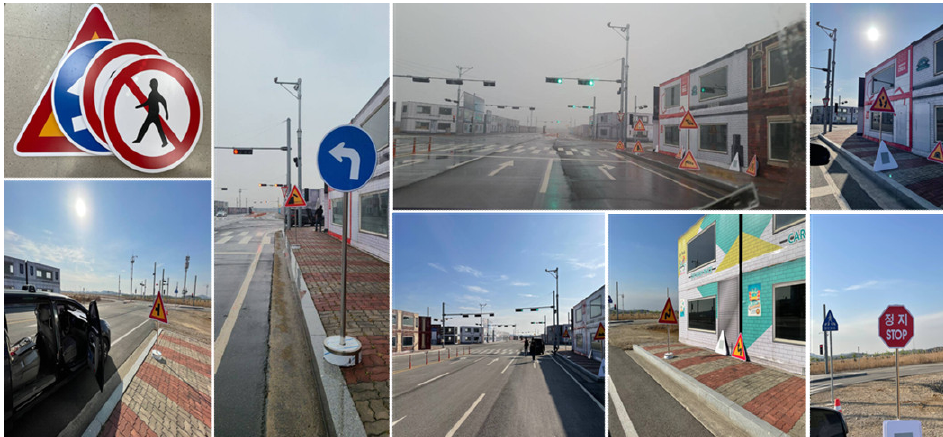
Figure 10. Image data collection field photography in K-CITY facility.